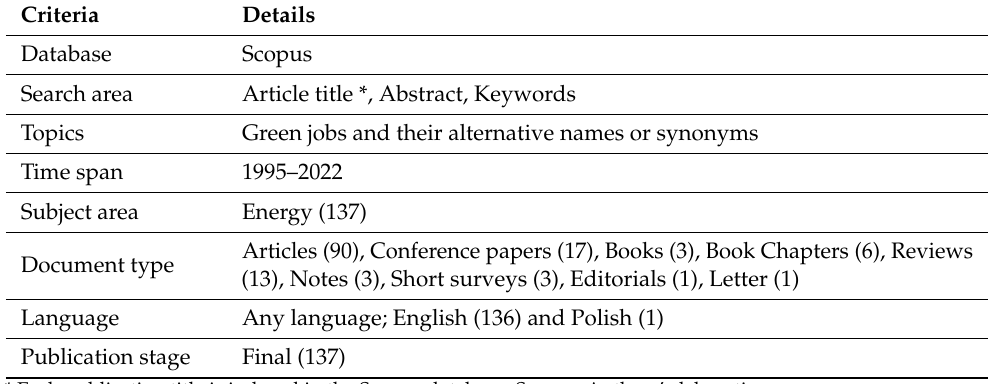
Table 1. Search Criteria for the IV stage of the performed research.